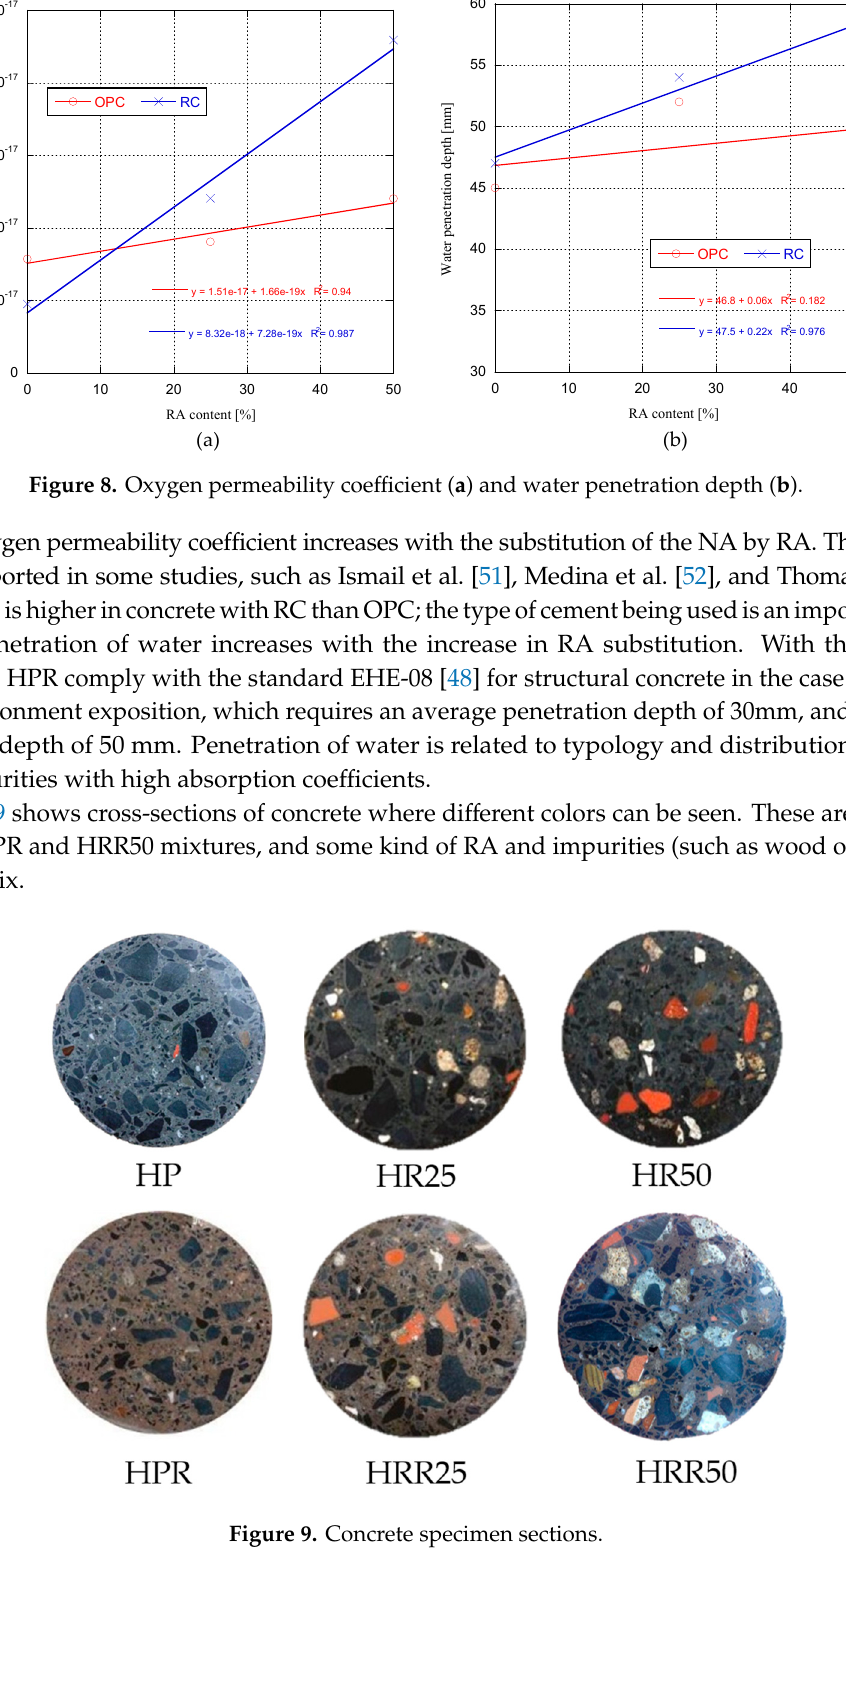
Figure 9. Concrete specimen sections.